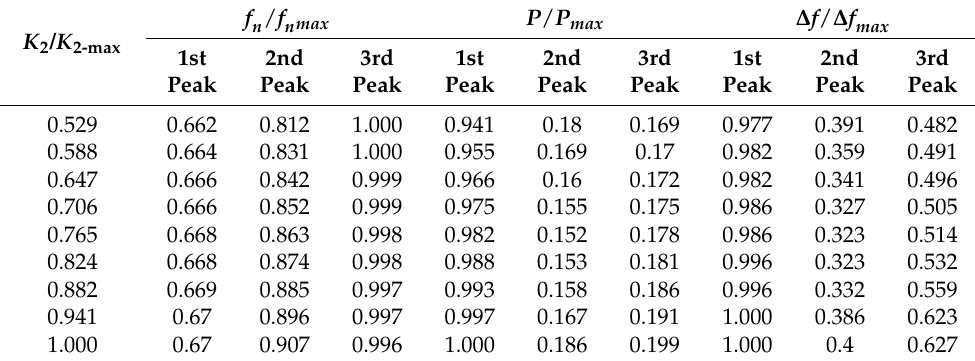
Table A9. Three bimorphs system—influence of K 2 spring constant connected to the external larger mass ‐ normalized values K 2 / K 2 ‐